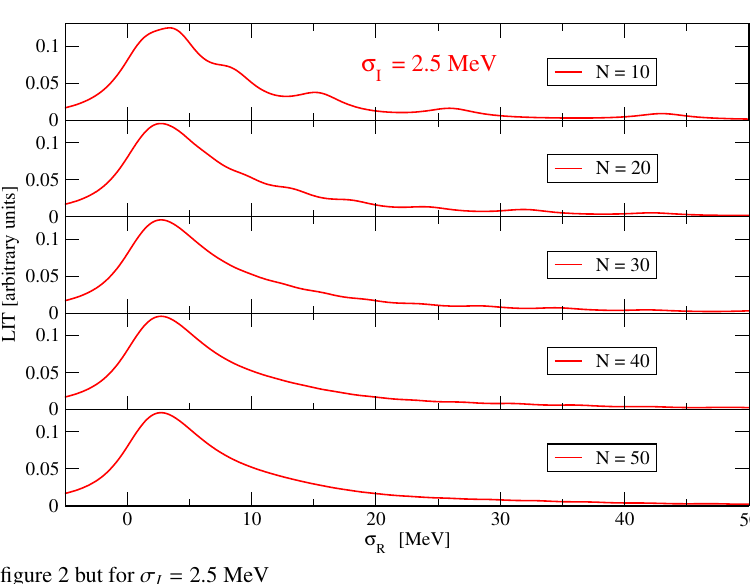
Figure 4. As (cid:2)gure 2 but for (cid:27) I = 2 : 5 MeV